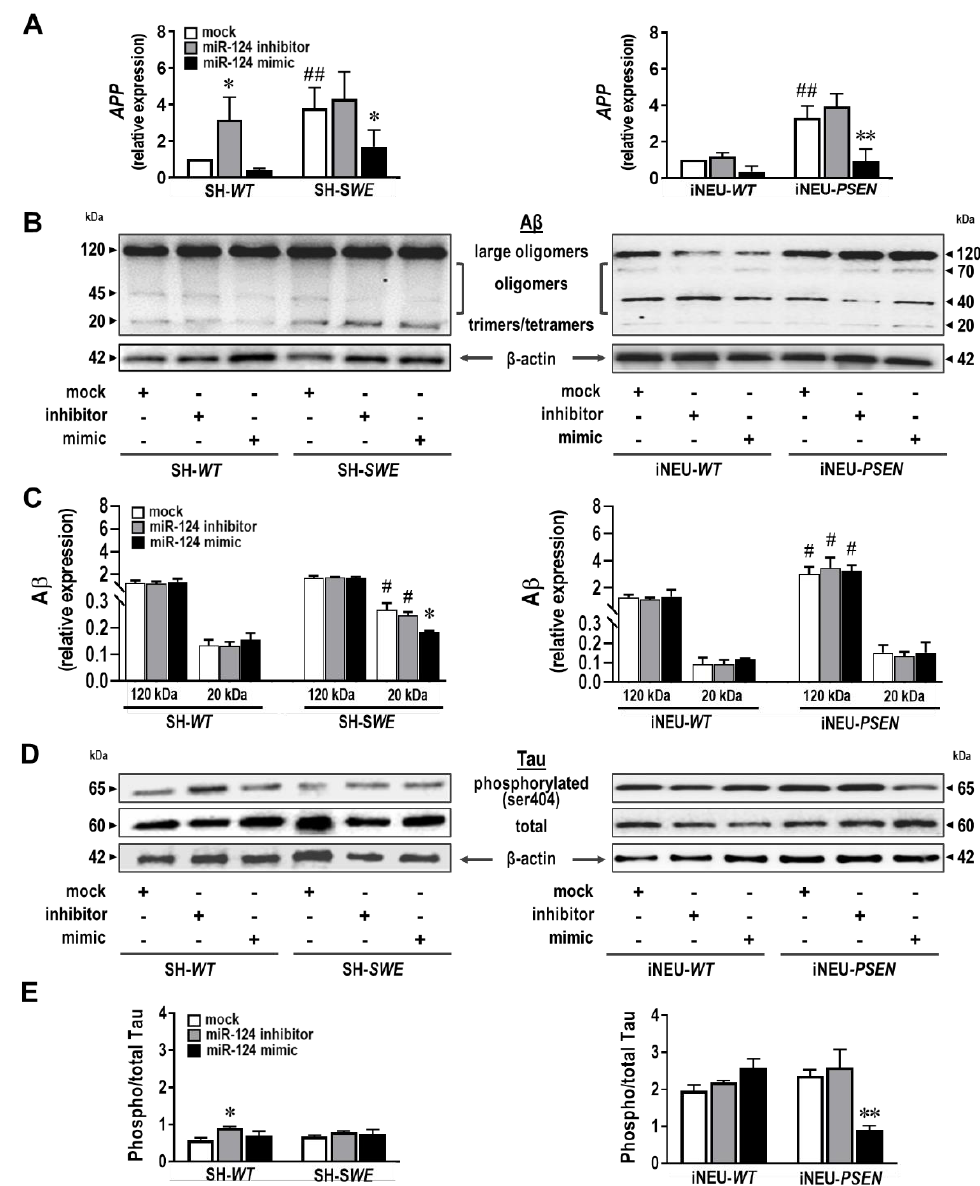
Figure 5. Effects of miR-124 modulation on APP transcription, Aβ accumulation and Tau phosphor- ylation in SH -WT /SH- SWE and iNEU -WT /iNEU- PSEN cells. Cells were obtained, differentiated, and transfected, as detailed in Material and Methods. ( A ) Cellular quantification of APP gene ex- pression by RT-qPCR revealing a decrease in the mutated cells with the miR-124 inhibitor. ( B ) Rep- resentative Western blots for Aβ species showing different representation and predominance of bands at 120 and 20 kDa. ( C ) Quantification of small and large Aβ oligomers showing that the first are increasingly represented in SH- SWE cells and the later in iNEU- PSEN cells. ( D ) Representative Western blots for Tau phosphorylation status at serine 404. ( E ) Quantification of phospho-Tau/total- Tau ratio revealing a decrease in iNEU-PSEN cells by the miR-124 mimic. Results are mean ± SEM fold change from at least three independent experiments. * p < 0.05 and ** p < 0.01 vs. respective mock controls, one-way ANOVA with Bonferroni post-hoc test. # p < 0.05 and ## p < 0.05, between the same treatment in WT and mutated cells, two-tailed student’s t -test. miR, miRNA; SH- WT , human SH-SY5Y wild-type neurons; SH- SWE , human SH-SY5Y expressing the APP695 Swedish mutant protein; iNEU- WT , iNeurons derived from induced pluripotent stem cells (iPSCs) generated from a healthy control; iNEU- PSEN , iNeurons from iPSCs generated from a patient carrying the PSEN1 ∆ E9